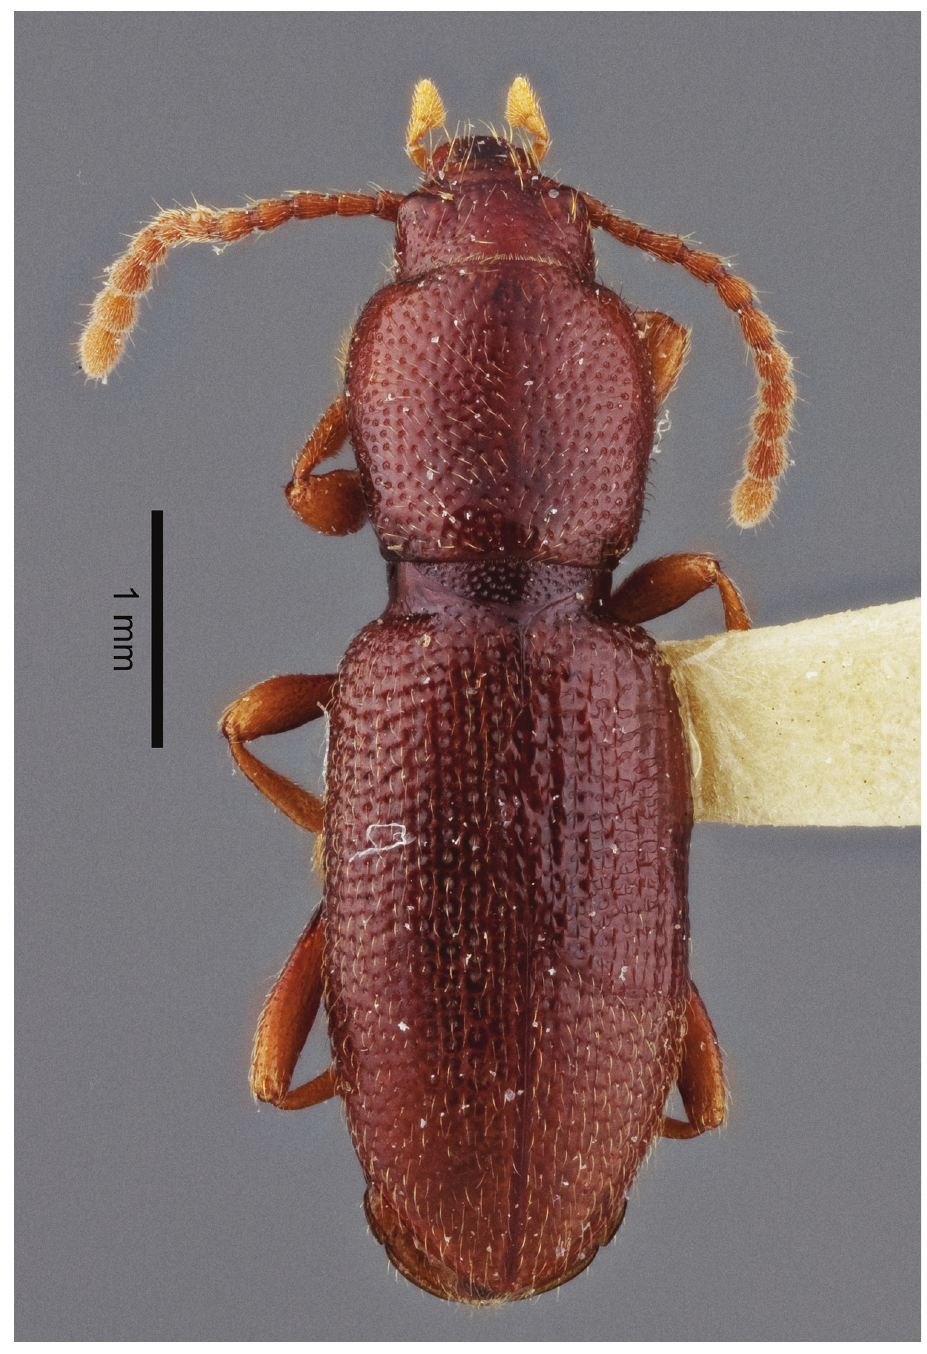
Figure 5. Dorsal habitus of Eschatoporis nunenmacheri